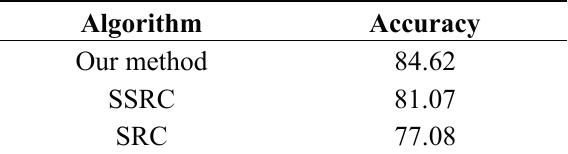
Figure 6. The cropped images of a subject in AR Face Database. ( a ) Neutral expression; ( b ) Expression changes; ( c ) Illumination changes; ( d ) Disguise with sunglasses; ( e ) Disguise with scarf. Table 2. The comparative recognition rates between SRC, SSRC and our method on the AR data set with different kinds of corrupted training